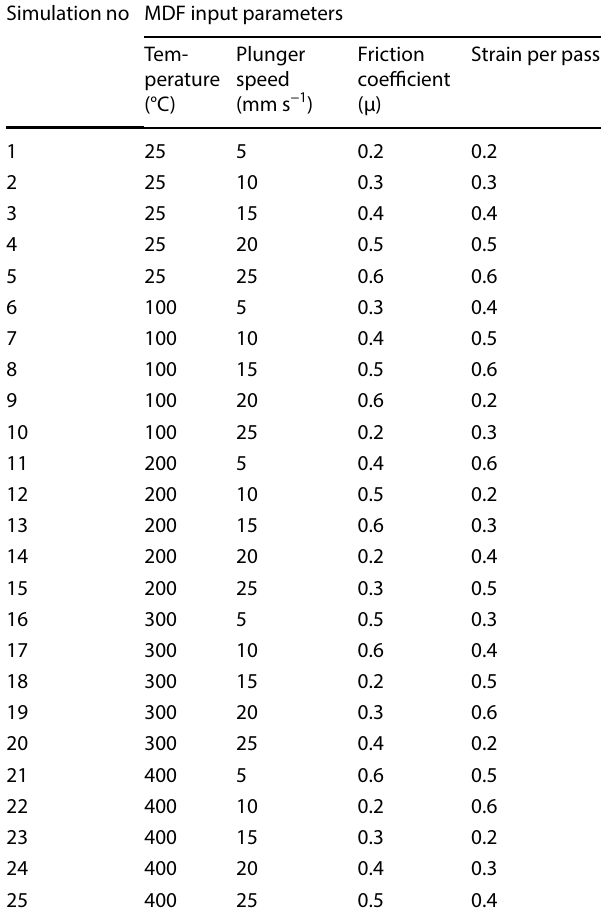
Table 2 L25 orthogonal array of Taguchi method of factors combi-